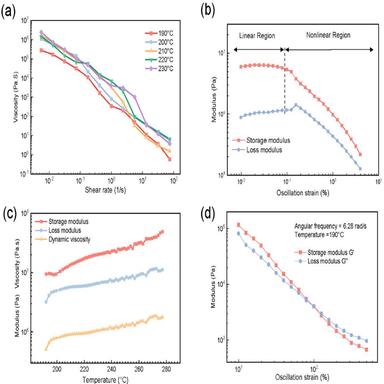
Rheological properties of binder-coated zirconia feedstock: (a) Viscosity vs. shear rate of feedstock at five different temperatures ranging from 190 ◦C to 230 ◦C. (b) Strain sweep on zirconia with binder materials at a constant angular frequency of 6.28 rad/s and a temperature of 190 ◦C. (c) Oscillatory temperature sweep tests of zirconia with binder materials at temperatures ranging from 180 ◦C to 280 ◦C. (d) Strain sweep for zirconia materials. Below 100% strain, the material behaves like a solid when G′